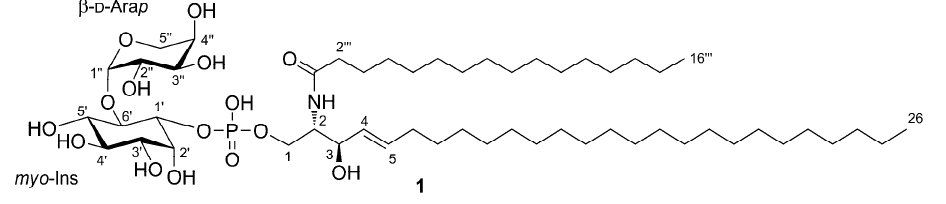
Figure 2. Structure of a representative homologue of zeamide ( 1 ).